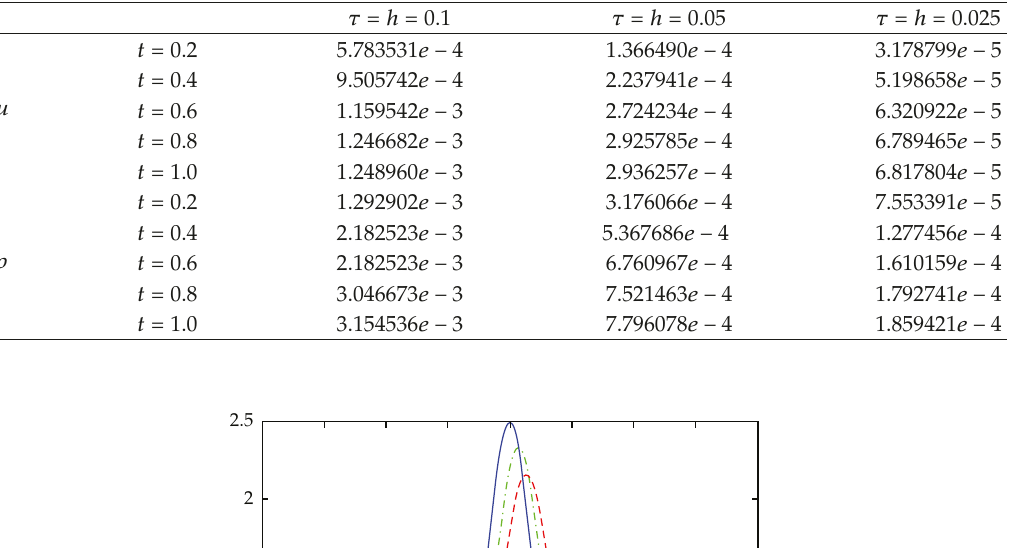
Table 1: The error ratios in the sense of l ∞ at various time steps.